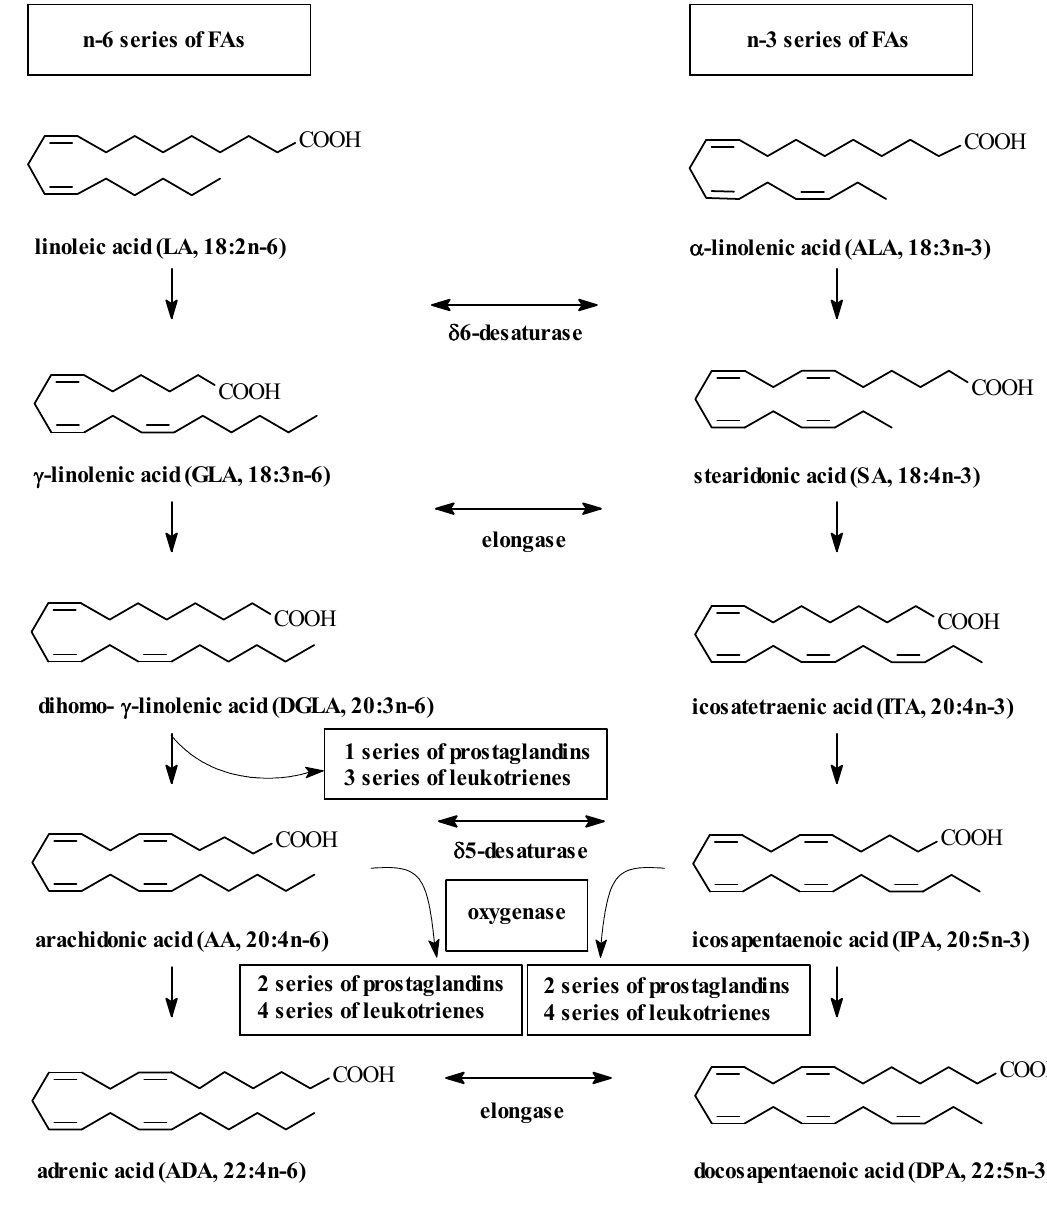
Scheme 1. Metabolic pathways of polyunsaturated fatty